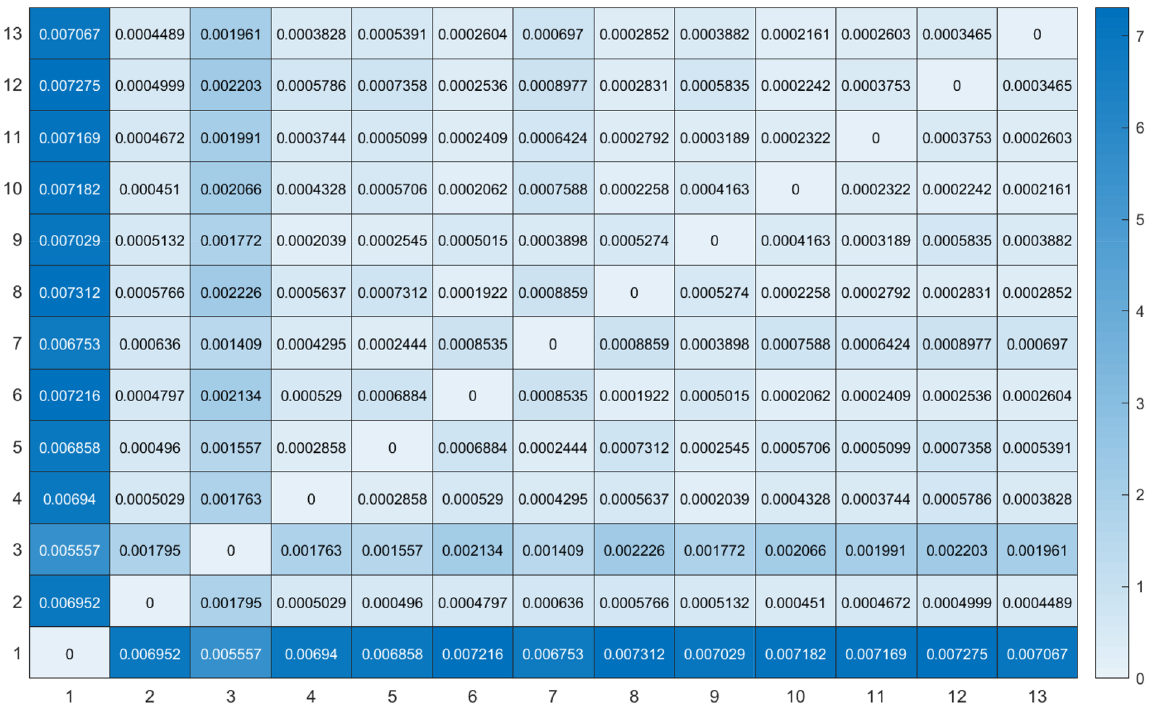
Fig. 3 The heat map of the Wasserstein distance matrix